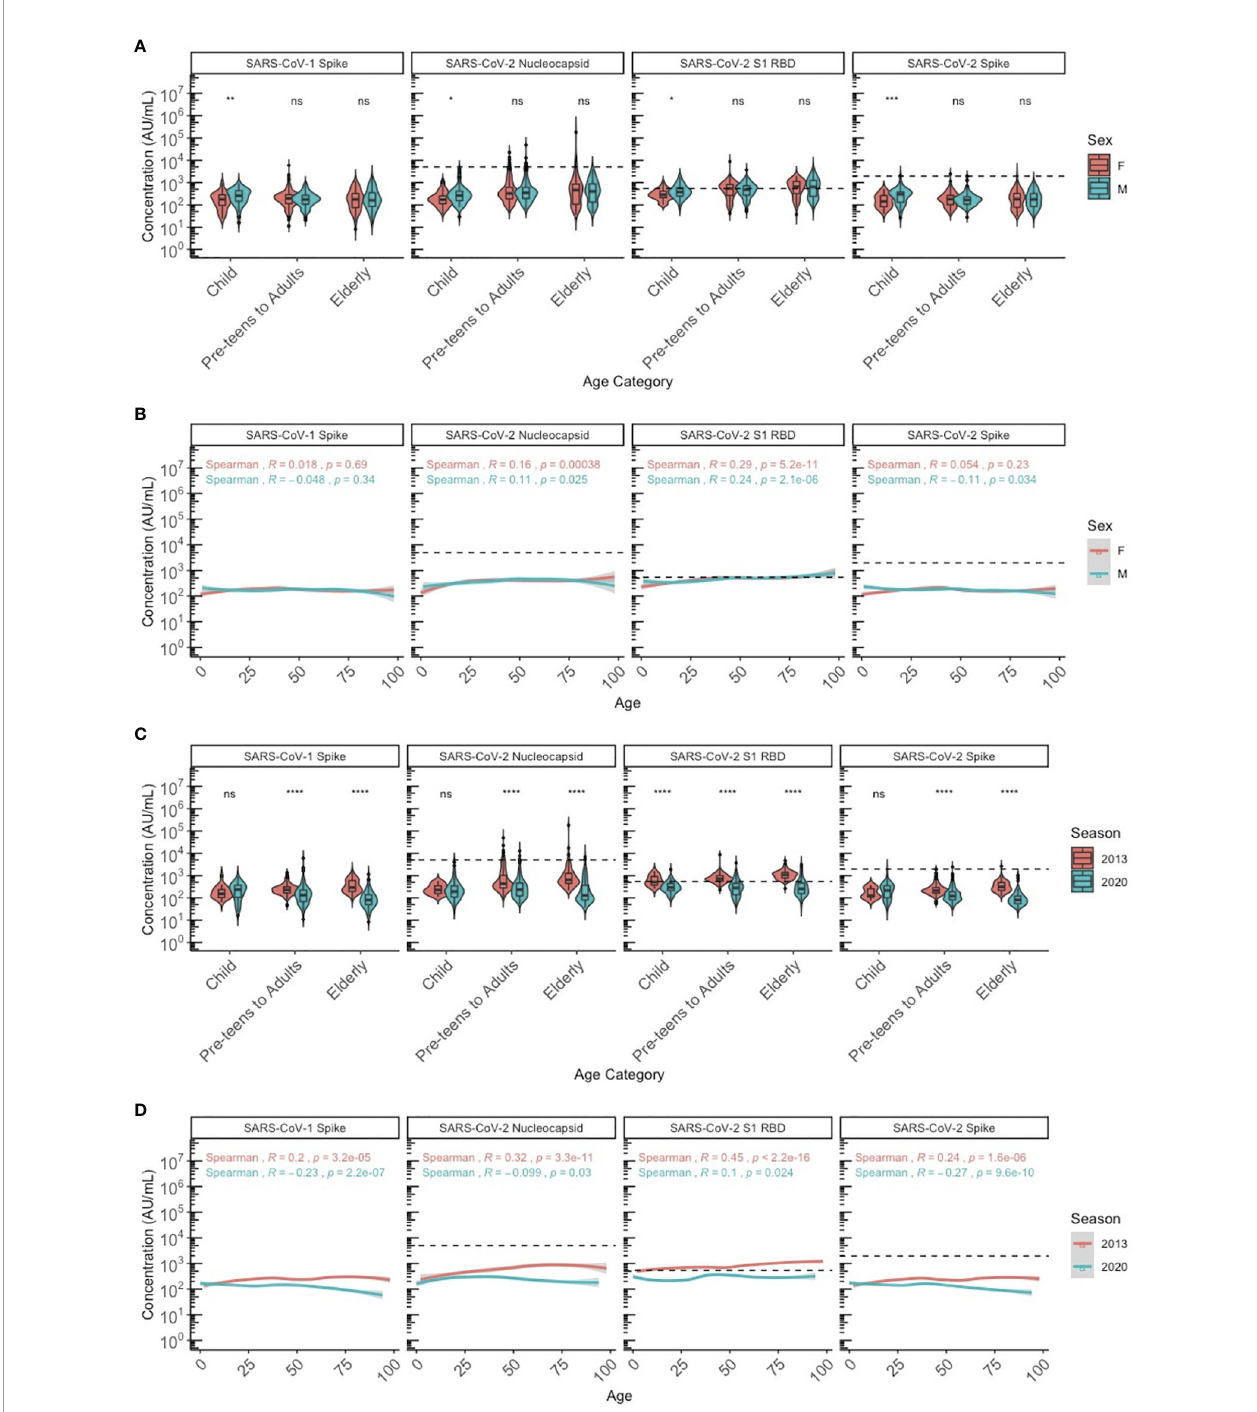
FIGURE 5 | SARS-CoV-1 Spike and SARS-CoV-2 S1 RBD, nucleocapsid and spike IgG antibody levels between sexes and seasons by age among SARS-CoV-2 sero-negative persons (N=887). (A, B) describe the SARS-CoV-1 and SARS-CoV-2 cross-reactive antibody levels between male and female sexes by (A) age category and (B) chronological age. (C, D) describe the SARS-CoV-1 and SARS-CoV-2 cross-reactive antibody levels between 2013 and 2020 seasons by (C) age category and (D) chronological age. In (A-C) , age categories are strati fi ed according to children ( ≤ 10 years old), pre-teens to adults (11-69 years old), and the elderly ( ≥ 70 years old). Black dashed lines describe the positivity cutoff for SARS-CoV-2 targets. Wilcoxon rank sum test was used to compare antibody levels between (A) sexes and (C) seasons. Spearman ’ s rank correlation was used to describe the relationship between antibody level and age in (B, D) , and Spearman ’ s correlation coef fi cient rho (R) and corresponding P-values (P) are reported. ns, not signi fi cant, * = p < 0.05, ** = p < 0.01, *** = p < 0.001 **** = p <